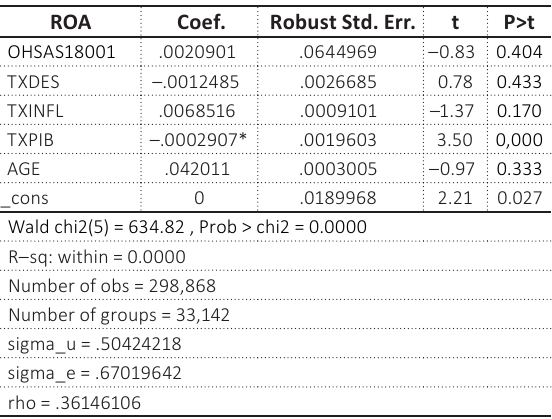
Table 7. Results of the OHSAS18001 regression model